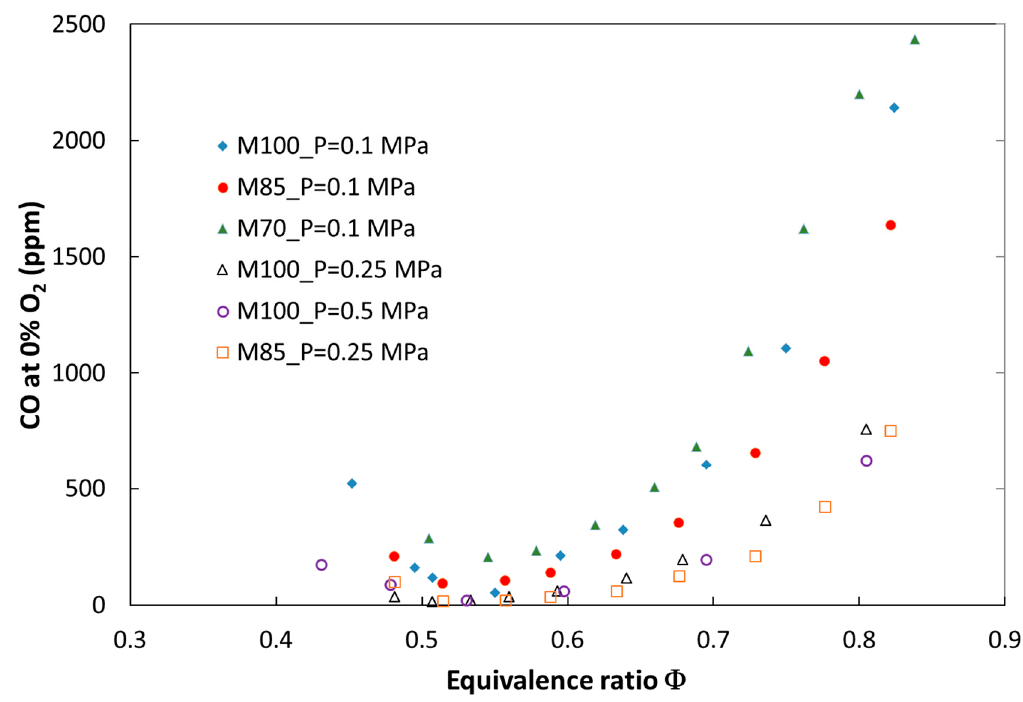
Figure 7. Experimental CO emission at elevated combustion pressure (P = 0.25 MPa) versus equivalence ratio.